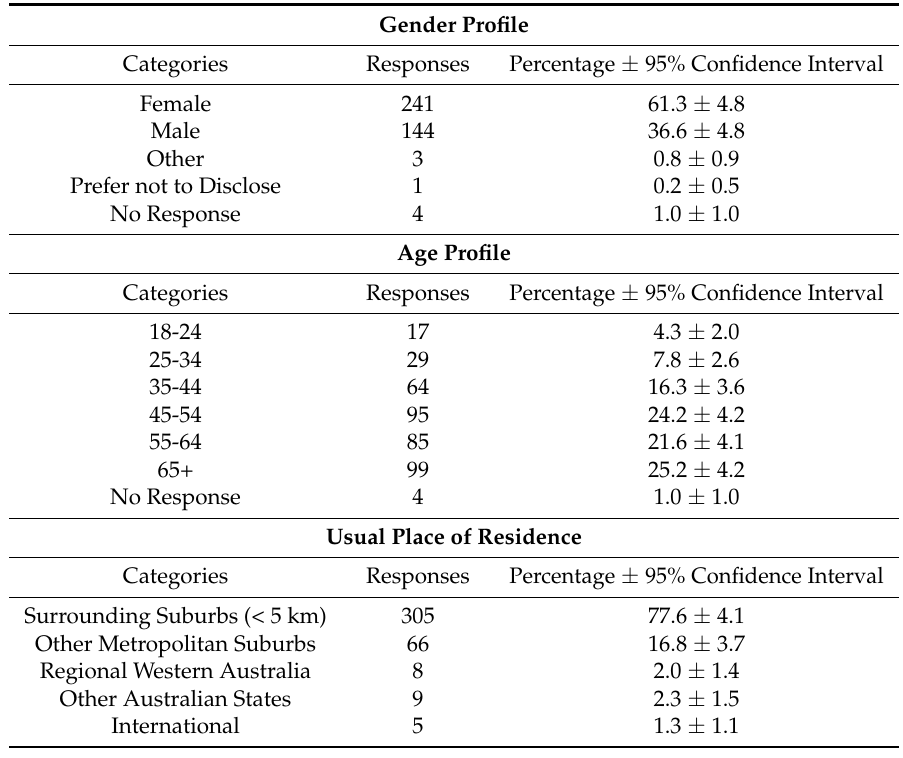
Table 1. Demographic profile for PGI users at Lake Claremont (n = 393) in the Austral summer of